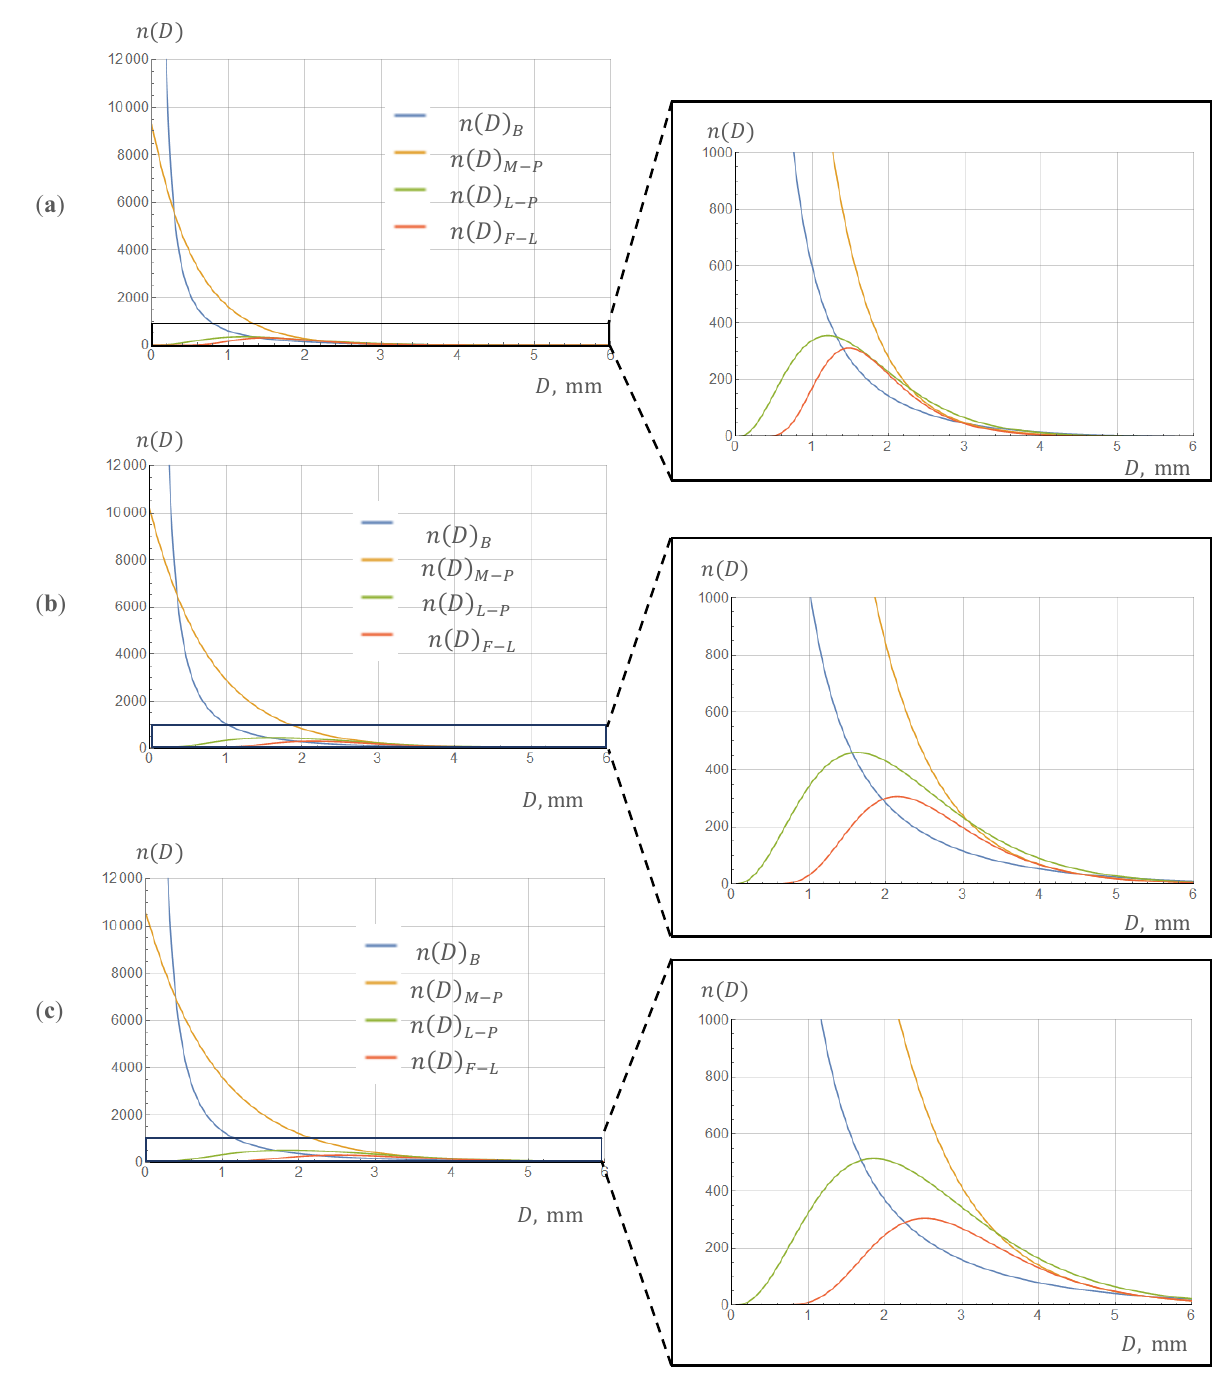
Figure 2. Droplet diameter distributions for different intensities R : ( a ) 72 mm/h; ( b ) 320 mm/h; ( c ) 720 mm/h.